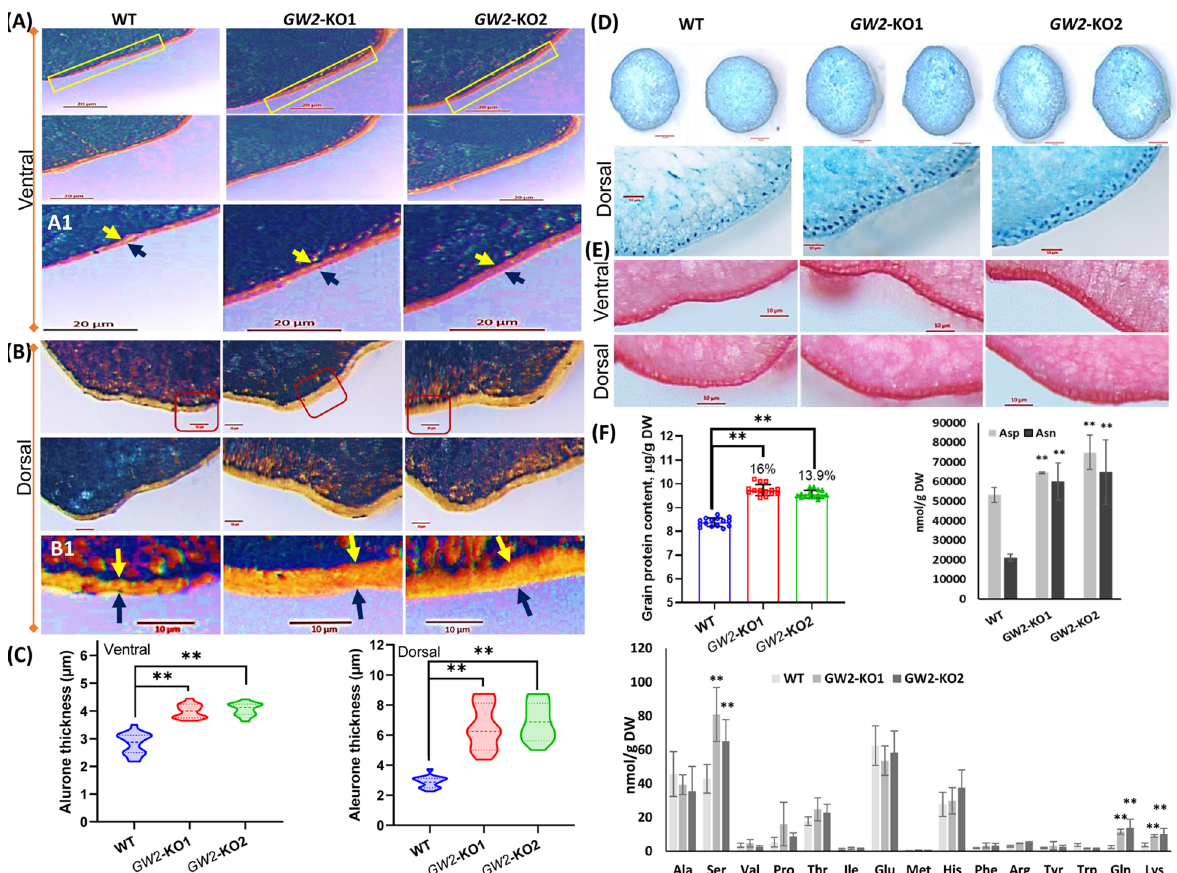
Figure 2. Characterization aleurone density and grain protein content of GW2-KO mutant. Transversally sectioned (1–2 mm size) dehusked mature rice grains from WT and GW2 -KO lines, stained with iodine solution for visualization aleurone morphology. The ventrolateral ( A ) and dorsolateral ( B ) section showing aleurone layer morphology of the WT and GW2 -KO lines. Magnified visualization of ventrolateral (A1) and dorsolateral (B1) sections of rectangular box from ( A , B ). ( C ) The aleurone layer density of GW2 -KO lines significantly p ≤ 0.01 (**) improved both in ventral and dorsal surface compared to WT seed. Arrowheads indicate the aleurone layer thickness. ( D ) The transversally sectioned (1–2 mm size) rice grains from WT and GW2 -KO lines stained in Bradford reagent. The GW2 -KO mutants showed high intense dark blue color compared to WT seed. The lower figure represents the closer view of aleurone layer of WT and GW2 -KO lines. The aleurone layer of GW2 -KO exhibits more protein bodies compared to WT. The scale bar represents 10 or 20 µm respectively. Data ± SD (n = 15). ( E ) Transversally sectioned of WT and GW -KO mature grains, stained in 0.05% (w/v) Safranin. Both WT and GW -KO showed single aleurone cell layer morphologies. The GW2-KO mutants exhibited larger cell size in the aleurone layer compare to WT seed. ( F ) The grain protein content of GW2 -KO mutants was substantially increased ( p ≤ 0.01) compared to WT (n = 15). (G-H) The UPLC-MS/MS analysis of GW2 -KO seeds showed significantly p ≤ 0.01 (**) higher free amino acid accumulation (Ser, Gln, Lys, Asp and Asn) compared to WT. Data ± SD (n = Grain aleurone phenotyping and quantification of grain nutritional content.